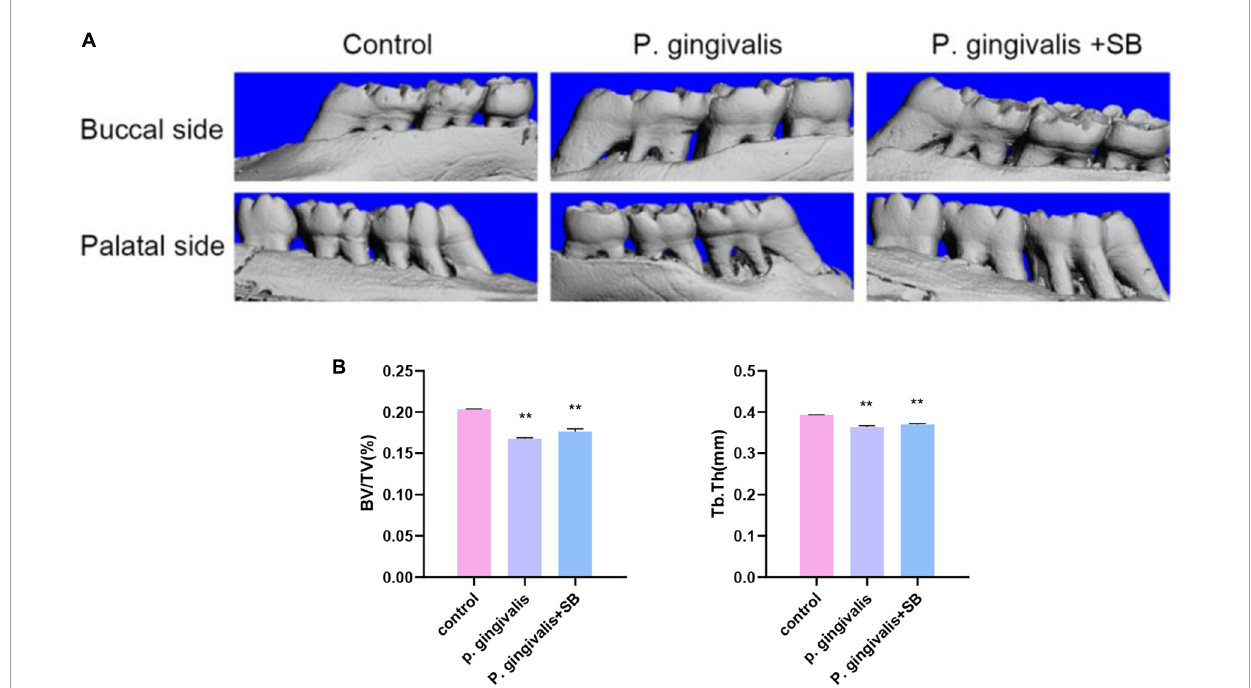
FIGURE2 Effects of topical application of P. gingivalis into the periodontal pocket of maxillary first molars on alveolar bone. (A) Images captured by micro-CT scanning of the molar region. Bone density analysis of alveolar bone including (B) BV/TV, Tb.Th. Experimental values are expressed as the mean ± SEM ( n = 3 per group). ** p < 0.01 compared with the control